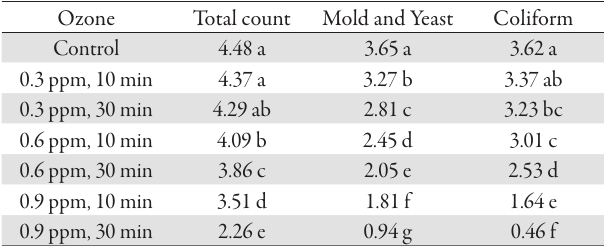
Tab. 2. Mean squares of microbial load at different Ozone gas concentration